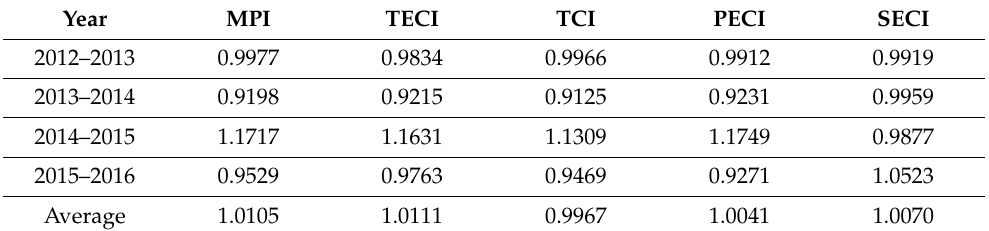
Table 3. Malmquist productivity index and component-by-time change